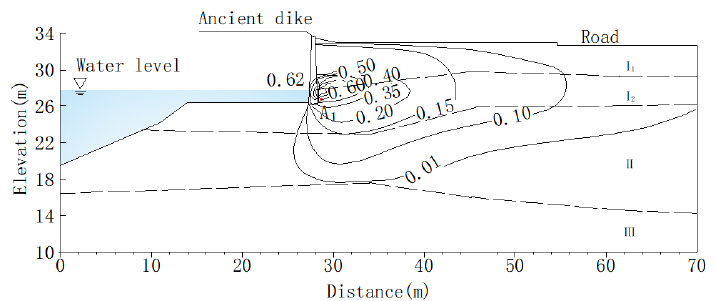
Figure 15. Hydraulic gradient distribution diagram of the original structure of the ancient riverbank.